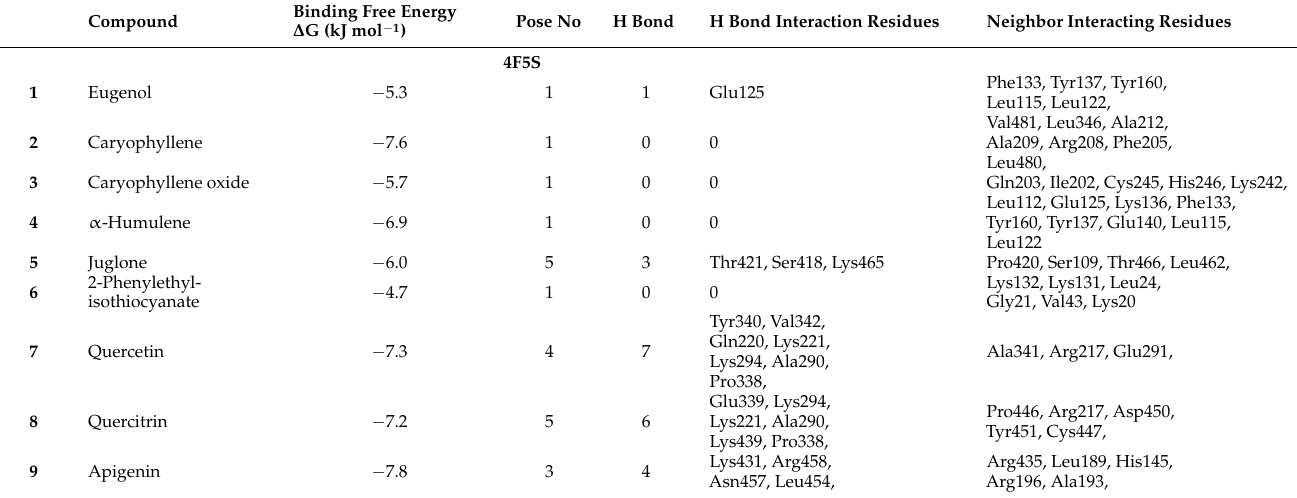
Table 3. Docking score, H- and non-H bonding interactions of test compounds with transcriptional regulator 4F5S